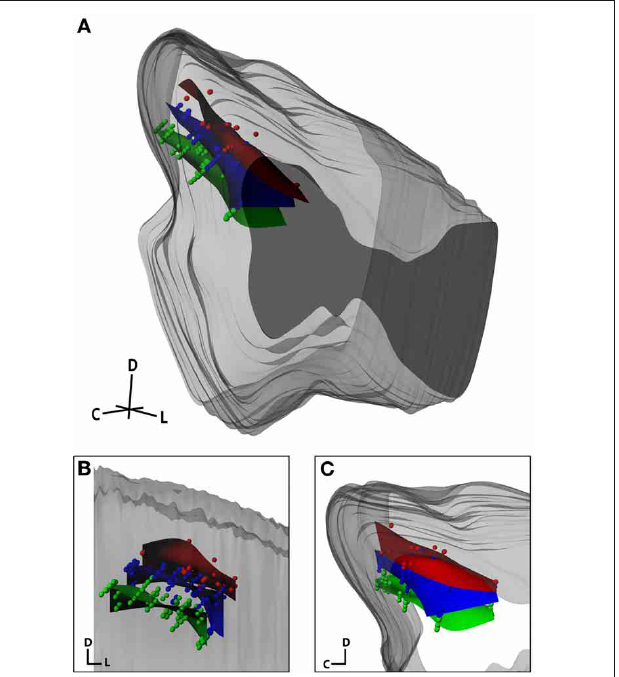
FIGURE 12 | Isofrequency laminae from three midbrains that were aligned and normalized together and shown within the standard midbrain in an isometric view (A), and magnified in a caudal (coronal; B) and lateral (sagittal; C) view. Dots correspond to individual electrode sites with best frequencies measured in vivo via frequency response maps. The curved planes were created in Rhinoceros as a best-fit to the electrode sites. The red, blue, and green planes correspond to low frequency (2–3.2kHz; n = 26), middle frequency (5–8kHz, n = 72), and high frequency (10–16kHz, n = 80) sites, respectively. C, caudal; D, dorsal; L,